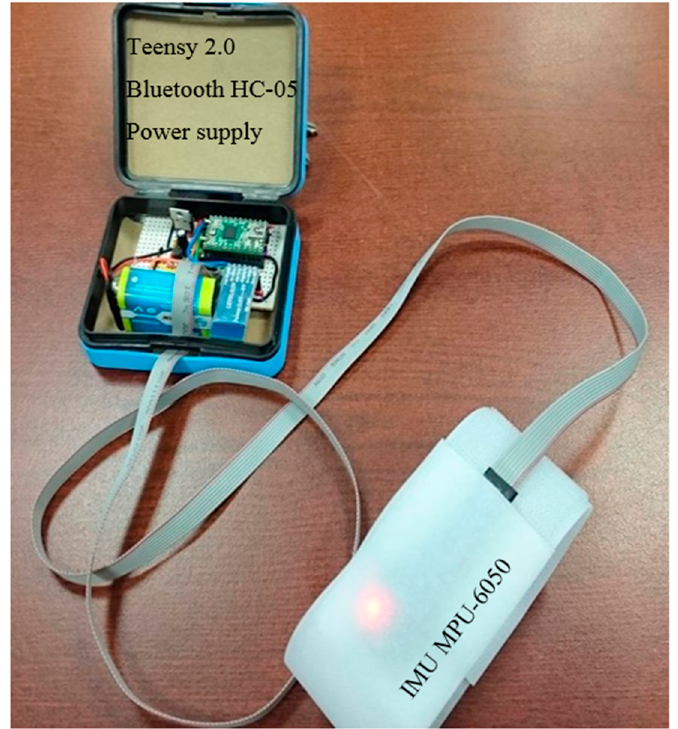
Figure 4. Portable foot attitude measuring device.